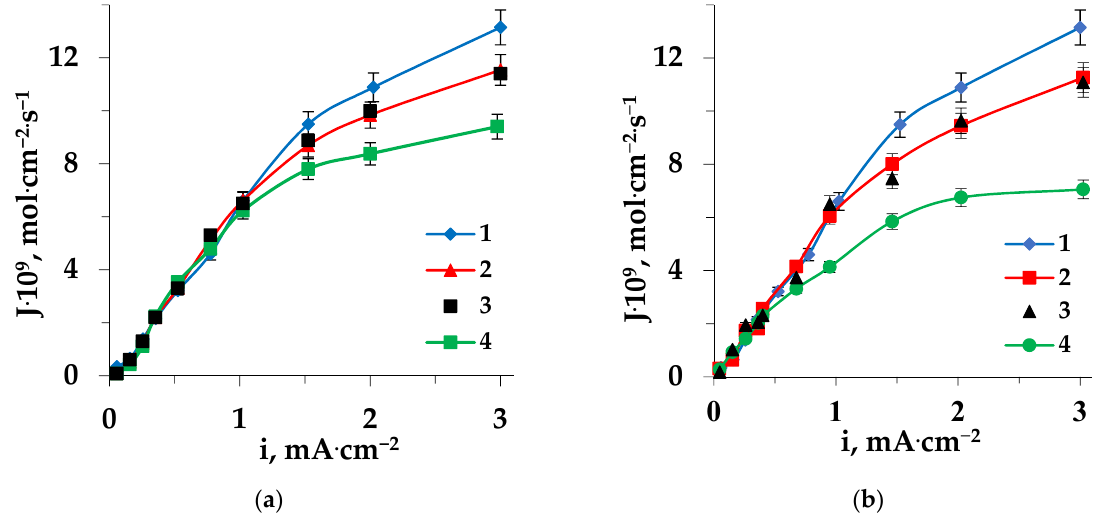
Figure 9. Dependences of chloride ions fluxes through the MA-41 membrane on the current density during electrodialysis of the solutions Trp + NaCl ( a ), Pro + NaCl ( b ): 1—pristine membrane during ED of NaCl solution, 2—pristine membrane, 3—regenerated membrane, 4—fouled membrane. After electrochemical regeneration of the ion-exchange membranes, amino acid fluxes through the MK-40 and MA-41 membranes returned to their original values for the pristine samples.